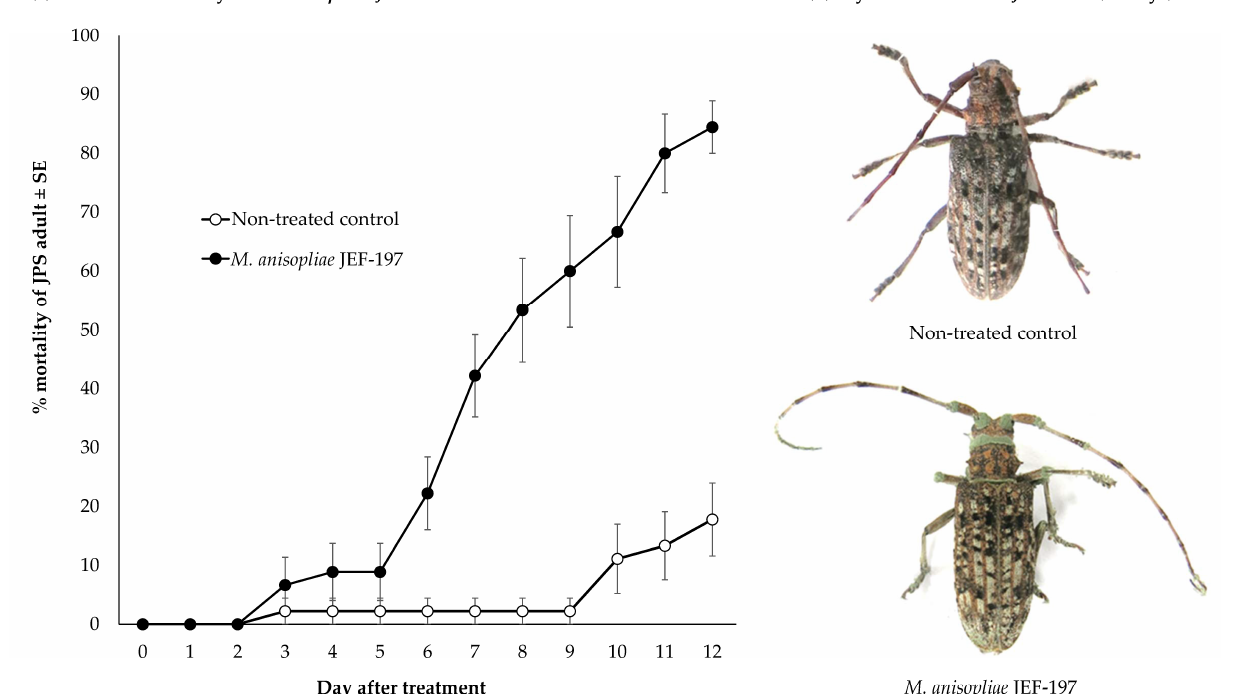
Figure 1. Characteristics of Japanese pine sawyer (JPS) beetle adults treated with the entomopathogenic fungus M. anisopliae JEF-197. JPS beetles were inoculated with M. anisopliae JEF-197 by spraying of a 1.0 × 10 7 conidia/mL conidial suspension, and the number of dead JPS adults was counted daily for 12 days. Beetles were maintained at a temperature of 25 ± 2 °C. Non-treated control JPS adults were sprayed with 0.03% siloxane solution. ( a ) Mortality of JPS beetles in response to M. anisopliae JEF-197 treatment. ( b ) JPS beetle symptoms induced by fungal infection.